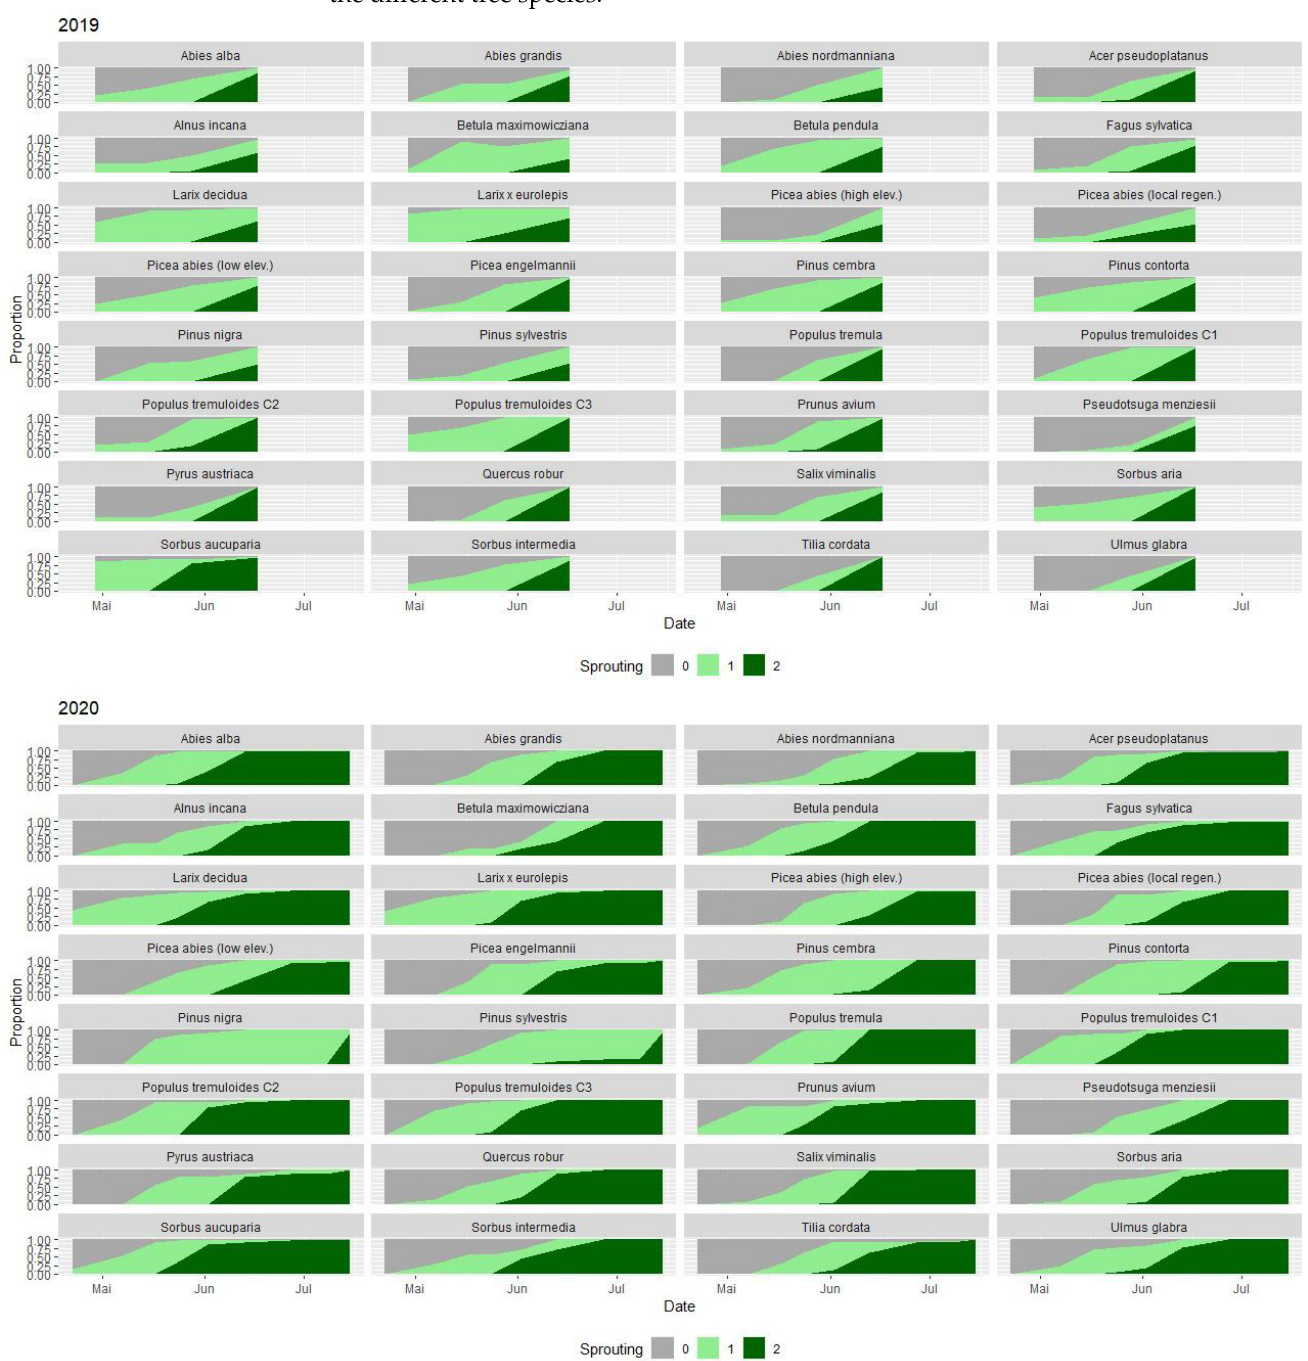
Figure 3. Temporal course of needle/leaf development at the experimental site of Wechsel in the springs of 2019 and 2020. Sprouting is classified as 0—no needles/leaves emerged, 1—needles/leaves partially developed, 2—needles/leaves fully